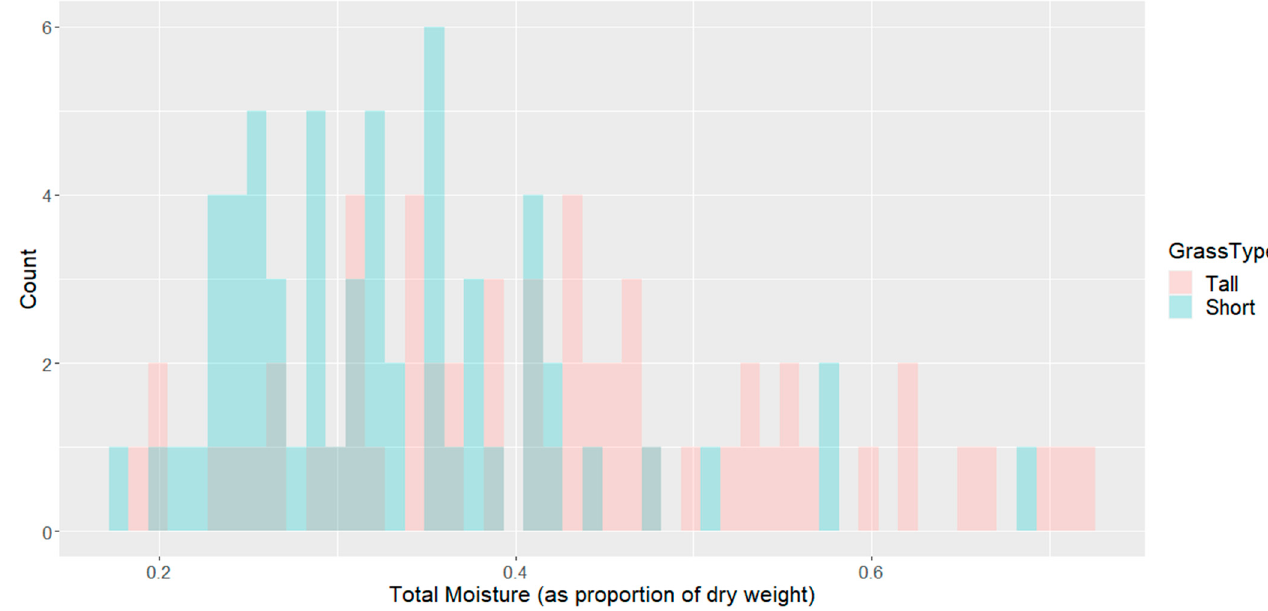
Figure 4. Fuel Moisture Distribution by Grass Type (Tall and Short).